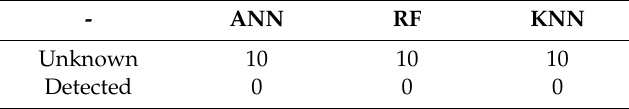
Table 6. Result of experiment with wrong inputs data.